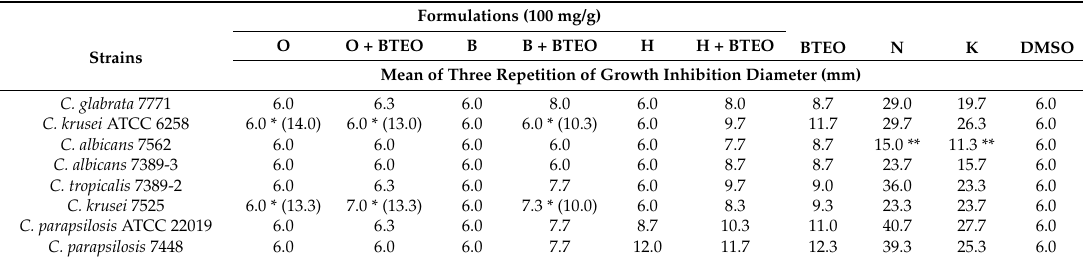
Table 3. Antifungal activity of selected oleogel, bigel, and hydrogel-based formulations in combination with BTEO (100 mg/g) against Candida spp. yeasts.